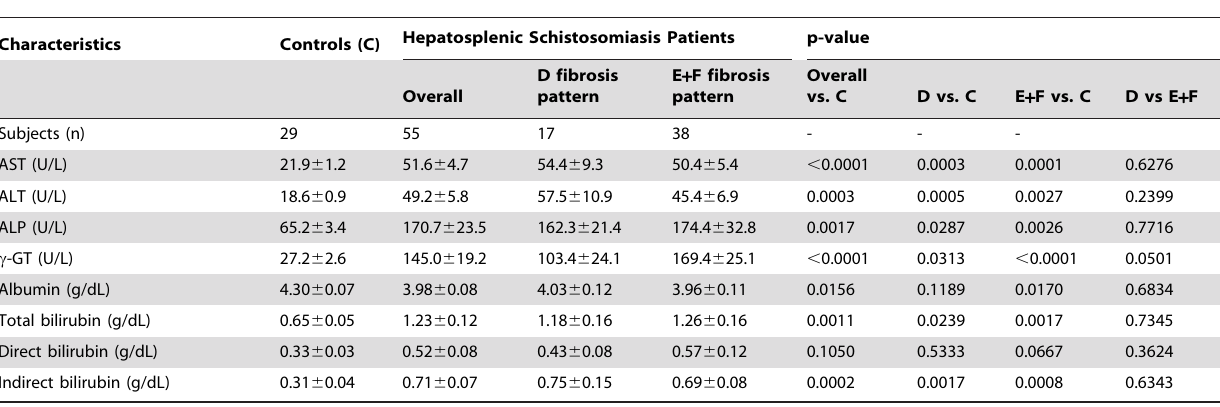
Table 1. Liver function tests in hepatosplenic schistosomiasis patients with different patterns of periportal fibrosis.